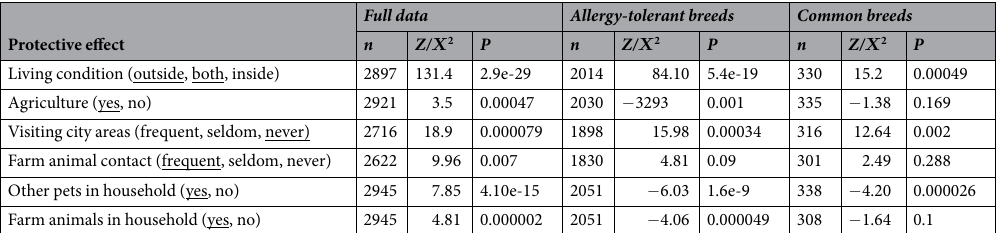
Table 2. The effect of several factors related to rural living in association with allergy score in dogs. Trinominal factors were tested with Kruskal-Wallis test and binominal factors with Mann-Whitney U-Test against allergy score. The protective factors are underlined. Visiting city areas and farm animal contact happened at the age of 4 weeks to 6